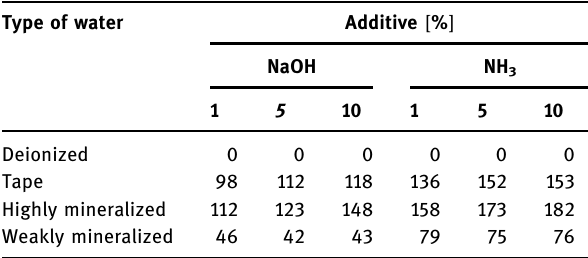
Table 4: Amount [ mg ] of precipitation after 120 min GP treatment Type of water